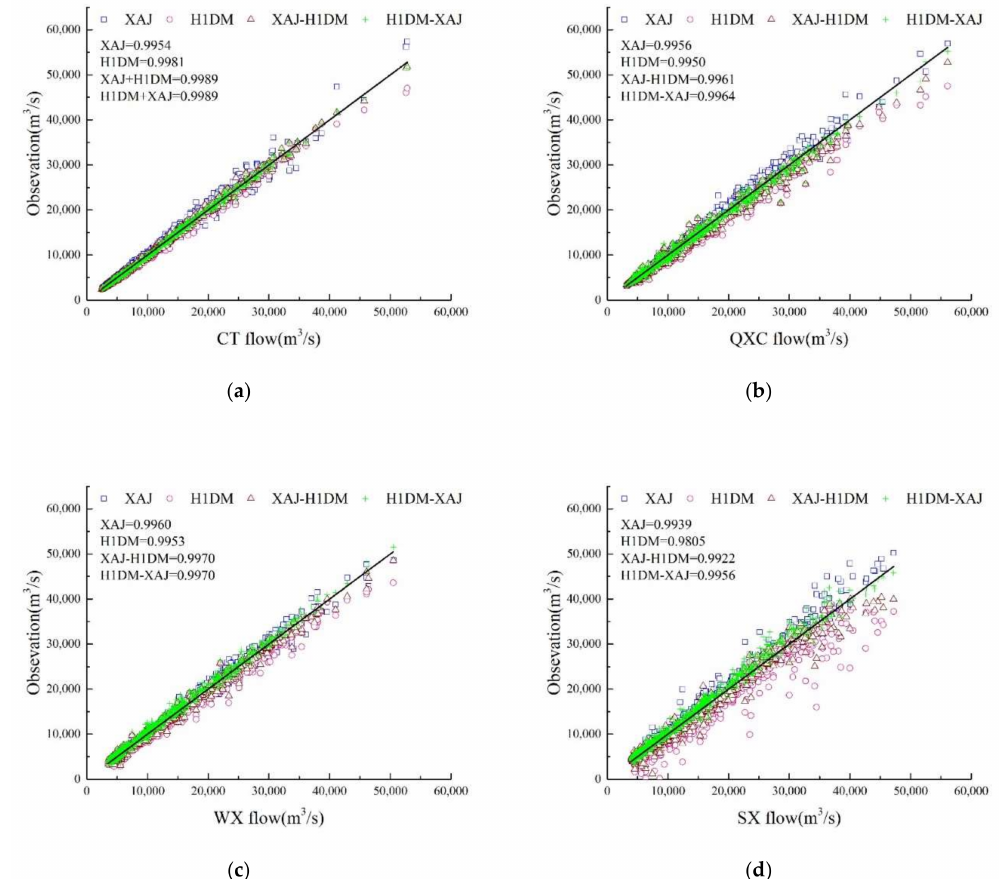
Figure 11. Flow scatter diagram and correlation coe ffi cient (R 2 ) of the four models in CT ( a ), QXC ( b ), WX ( c ), SX ( d ) for all